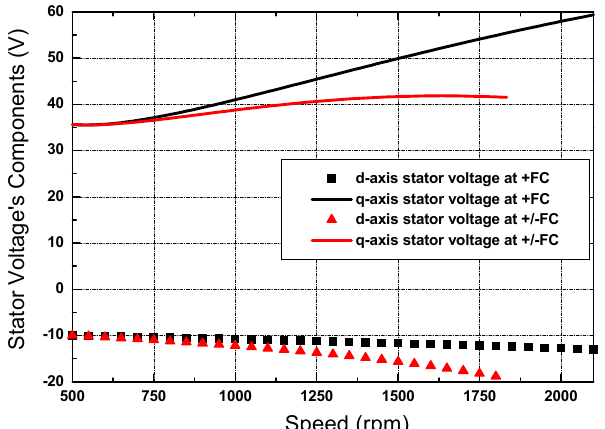
Figure 11. Stator voltage components at reduced positive and reversed FC.